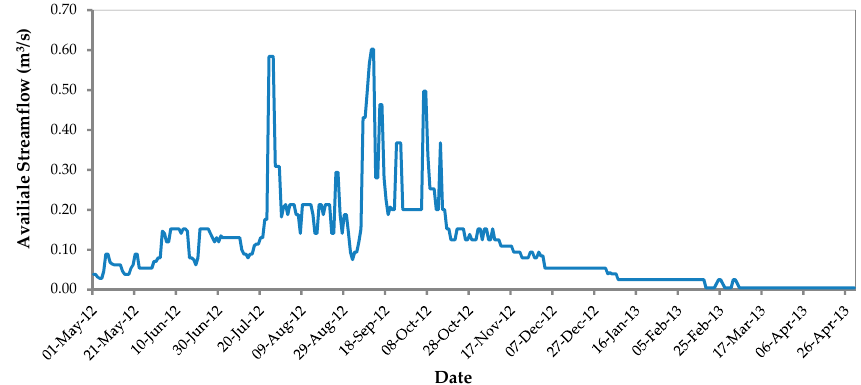
Figure 3. Daily available streamflow of the Baan Khun Pae River, May 2012–April 2013.